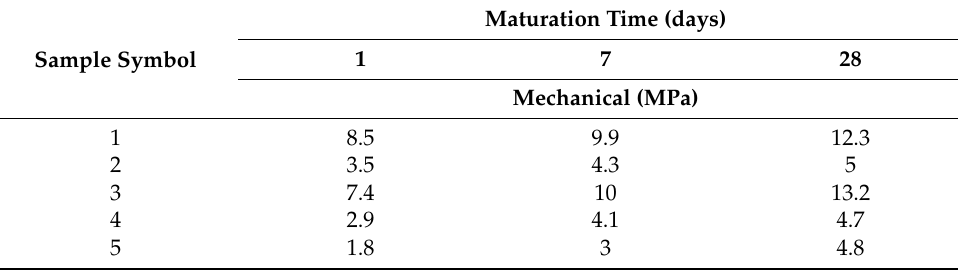
Table 9. Values of the mechanical strength under bending of the tested fireplace